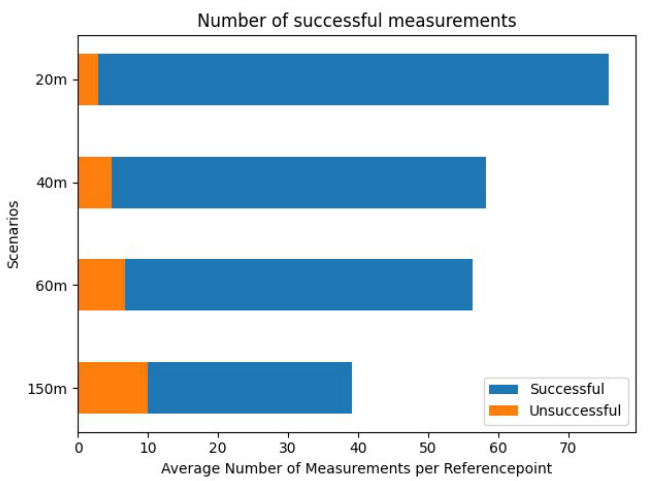
Figure 14. Number of successful and unsuccessful measurements of Reference Points. With a raising distance the number of successful measurements decreases.